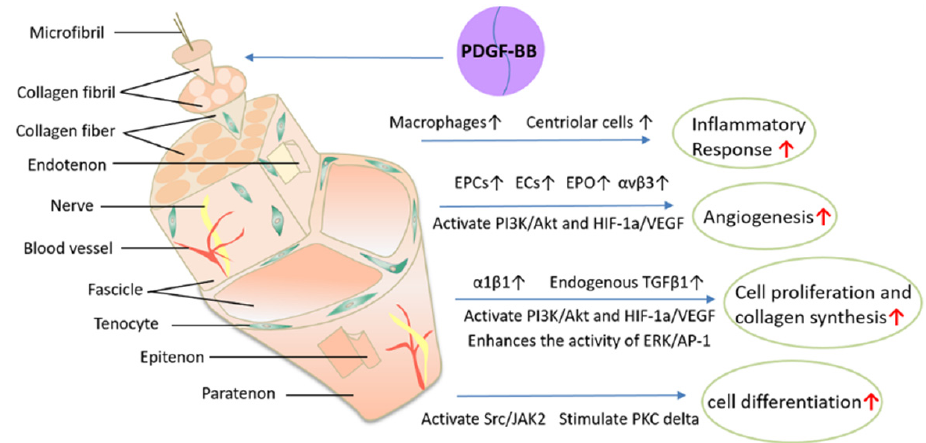
Figure 4. The mechanisms of PDGF-BB in tendinopathy. Black ↑ , increased; red ↑ , promoted.